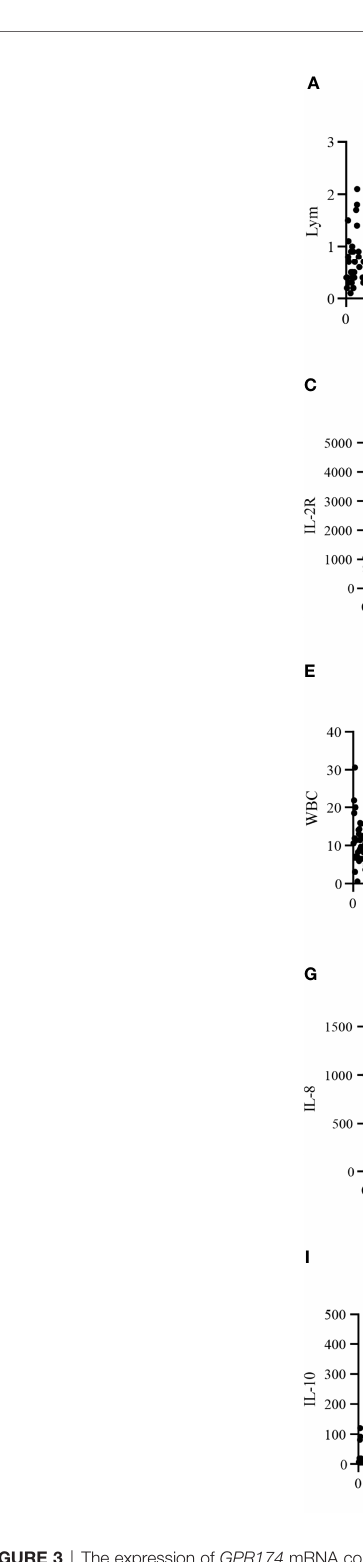
FIGURE 3 | The expression of GPR174 mRNA correlated with laboratory parameters in septic patients. (A – I) Correlation of the expression of GPR174 mRNA with the counts of WBC, Neu, and Lym, CRP, IL-2R, PCT, IL-6, IL-8, and IL-10 in patients with sepsis, respectively. Dots represent individual participants. P values less than 0.05 were considered statistically signi fi